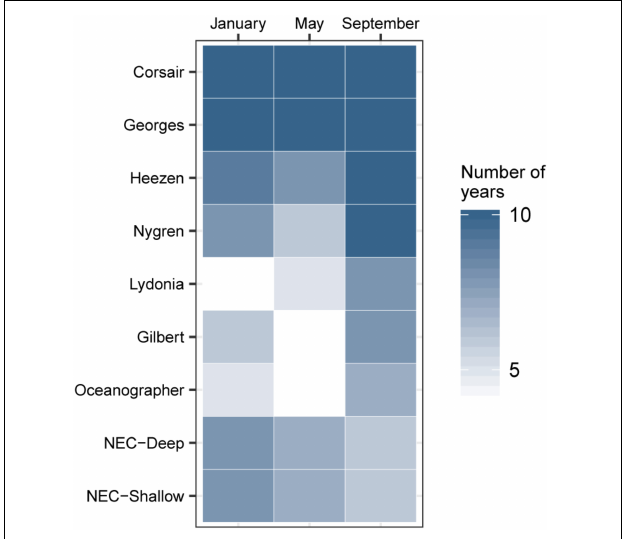
FIGURE 8 | Hydrodynamic connectivity based on occurrence (out of 10 years) observed between endpoints at the mouth of Corsair Canyon and zones of interest in January, May, and September between 2004 and 2013.